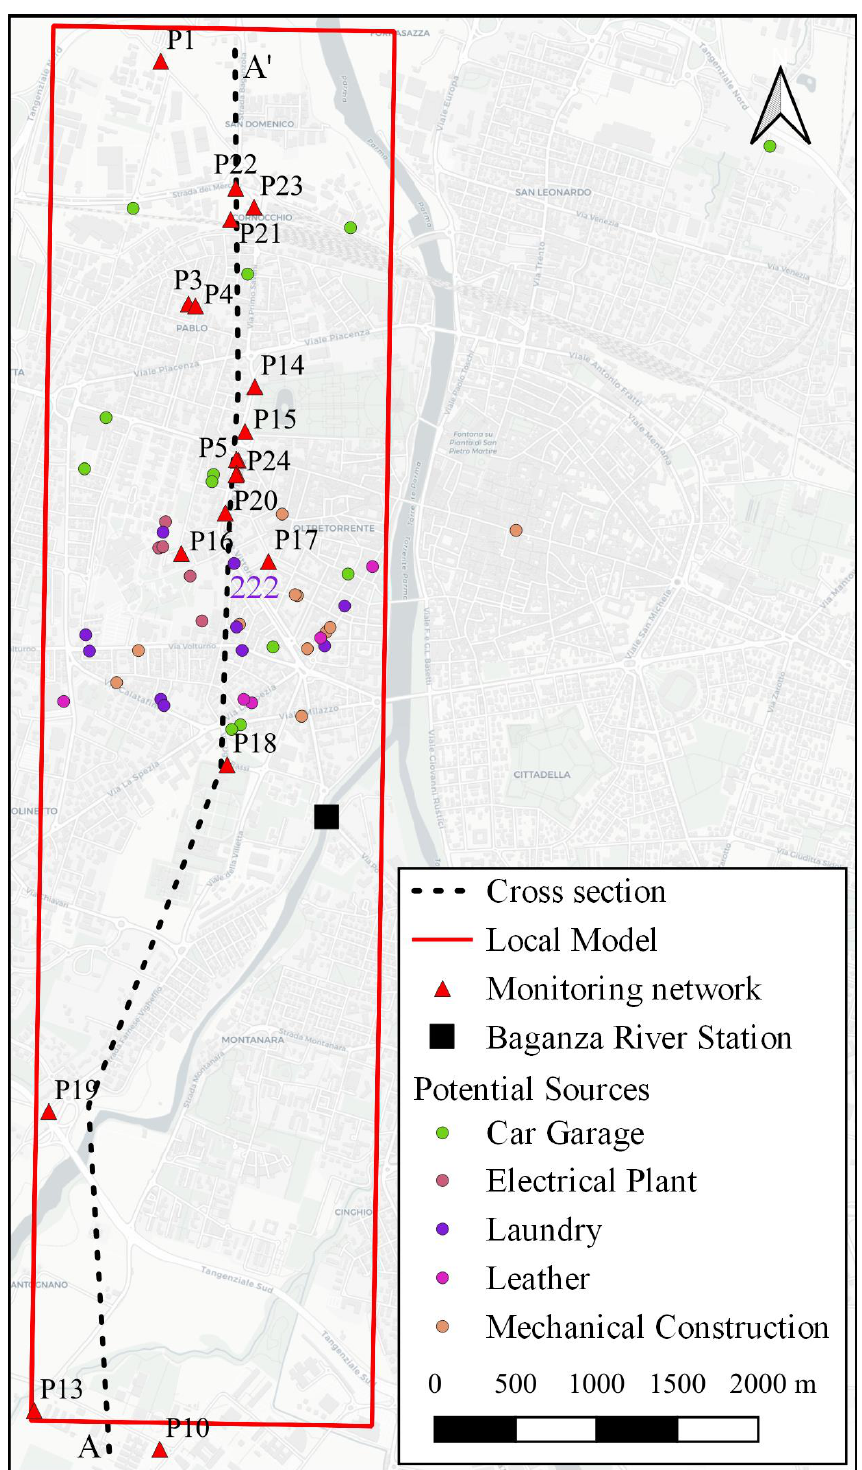
Figure 3. Study area. Detail of Figure 2 on local model, location of monitoring wells, potential sources, geological cross section AA’ , and river station. sources, geological cross section AA’, and river